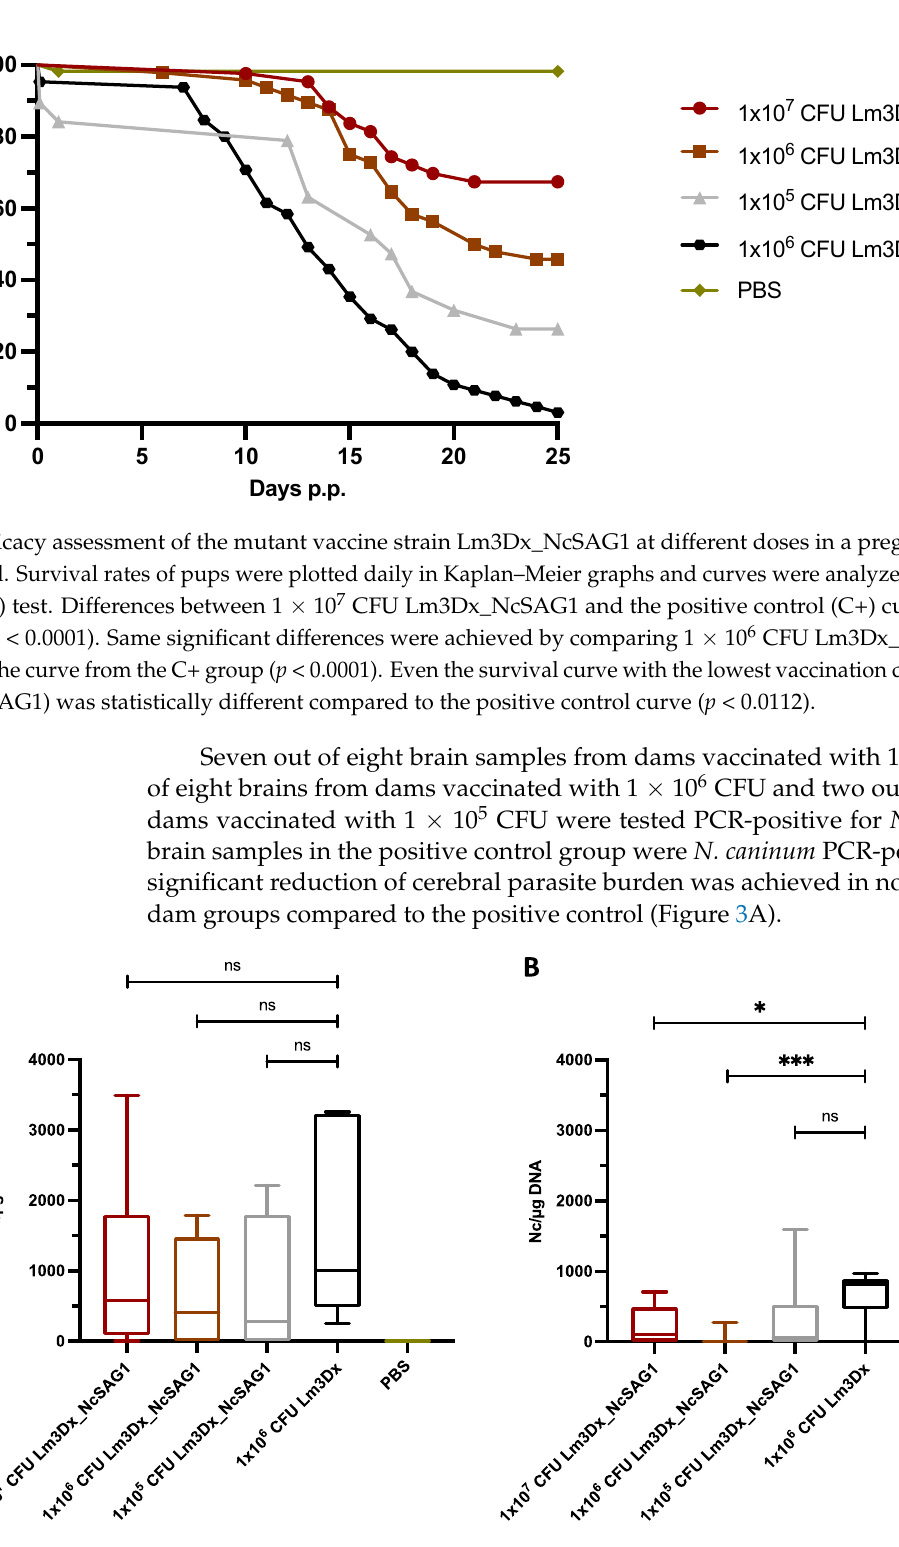
Figure 3. Evaluation of cerebral parasite load of dams ( A ), and non ‐ pregnant mice ( B ) by quantitative RT ‐ qPCR. Brain